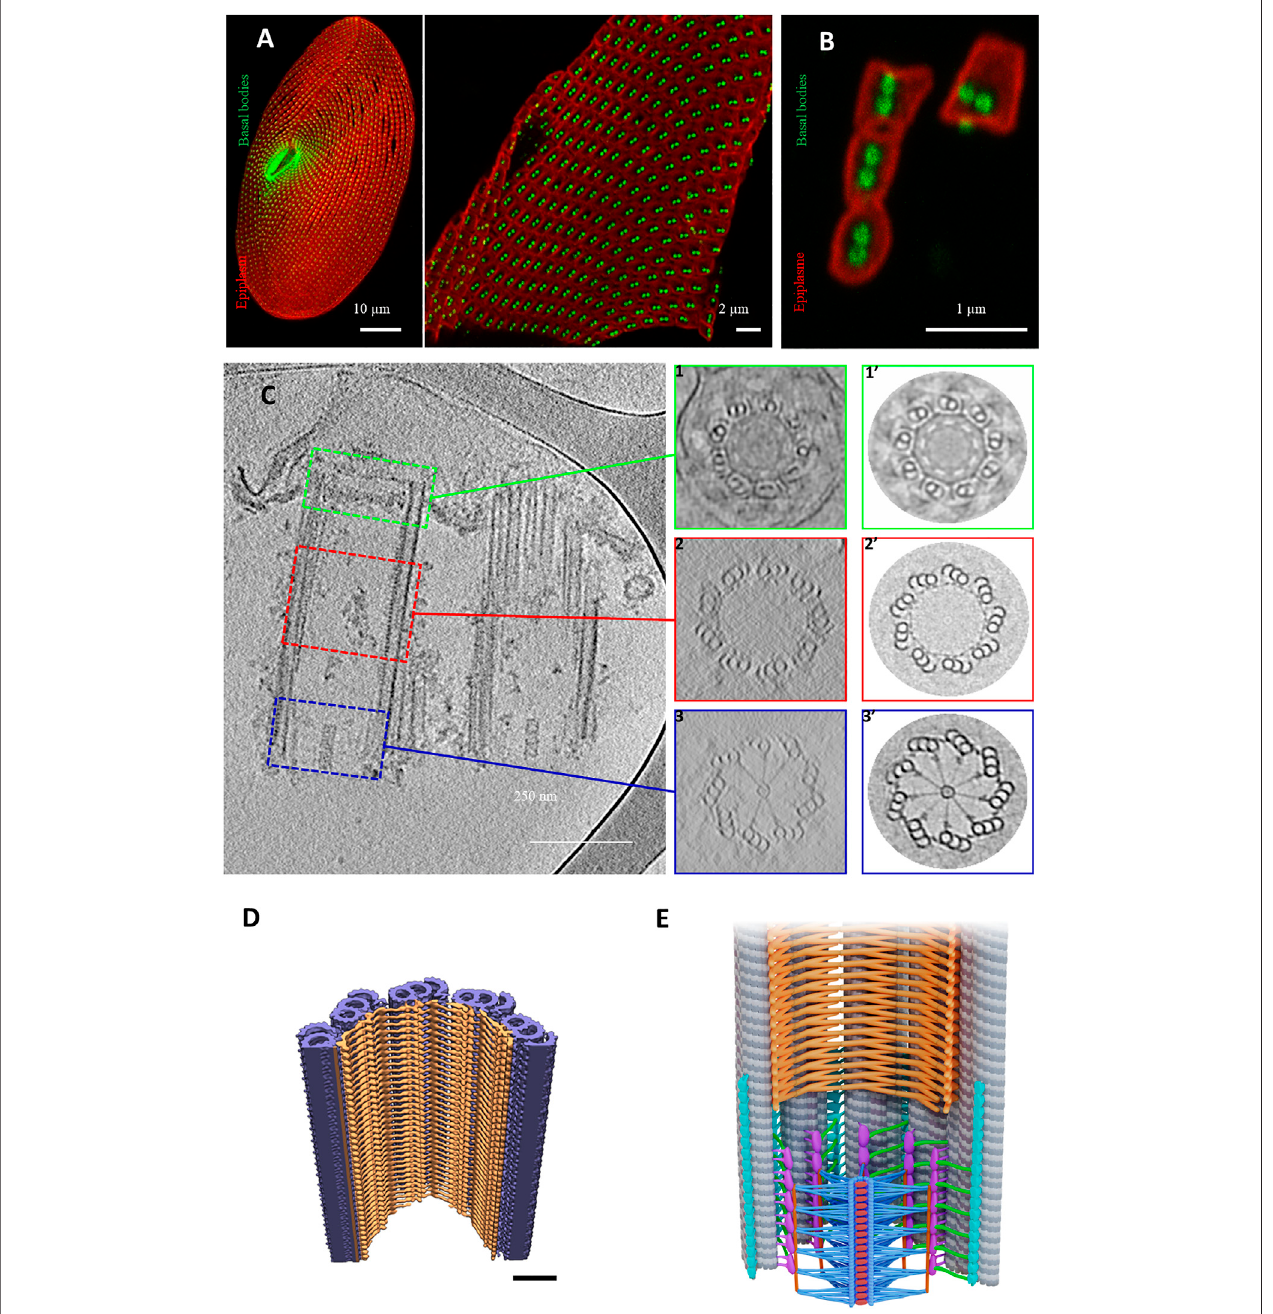
FIGURE 6 | Basal body organization in Paramecium tetraurelia . (A) left: Paramecium stained Basal bodies (BB) are decorated by polyclonal anti-glutamylated tubulin(green)andanti-epiplasminantibodies(red).Right:puri fi edParameciumcortexstainedwithanti-glutamylatedtubulin(green)andanti-epiplasminantibodies(red). Scale bar: 10 µm. (B) Puri fi ed basal body units obtained by 5 s of sonication. Scale bar: 2 µm. (C) Cryo-electron tomography of two Paramecium basal bodies. Z slice from a tomographic three-dimensional reconstruction showing a longitudinal section of a two basal body-cortical unit with the transition zone (green square), the central region (red square) and the proximal region (blue square). 1, 2, 3: Transverse projection of the cryo-tomogram at the respective three levels; 1 ′ , 2 ′ , 3 ’ : 9-fold circularizations have been applied to the transverse projection. 1-1 ′ , show the transition zone, 2-2 ′ show the central region of the basal body and 3-3 ′ show the basal body proximal region with the cartwheel structure inside. (D) The inner scaffold forms a dense helical lattice. Three-dimensional (3D) view of the ninefold symmetric centralregionsfrom Paramecium BB.Unrolledinnerscaffoldstructures.In Paramecium a2-starthelixisobserved(thepinkcolorindicatesonehelixwhiletheorangeone indicatedthesecondhelix). Adapted fromLeGuennec etal.,2020. (E) Cartoonofalongitudinalsection ofaBasalbody. Themicrotubulesareingrey,thecartwheelisin blue, CID in red, pinheads in violet, (A – C) linker in turquoise, triplet base in green and the inner scaffold in orange [Reprinted from (Klena et al., 2020; Le Guennec et